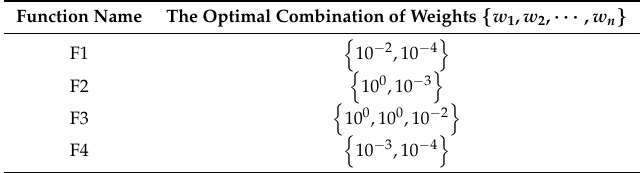
Table 3. The optimal combination of weights for the synthetic